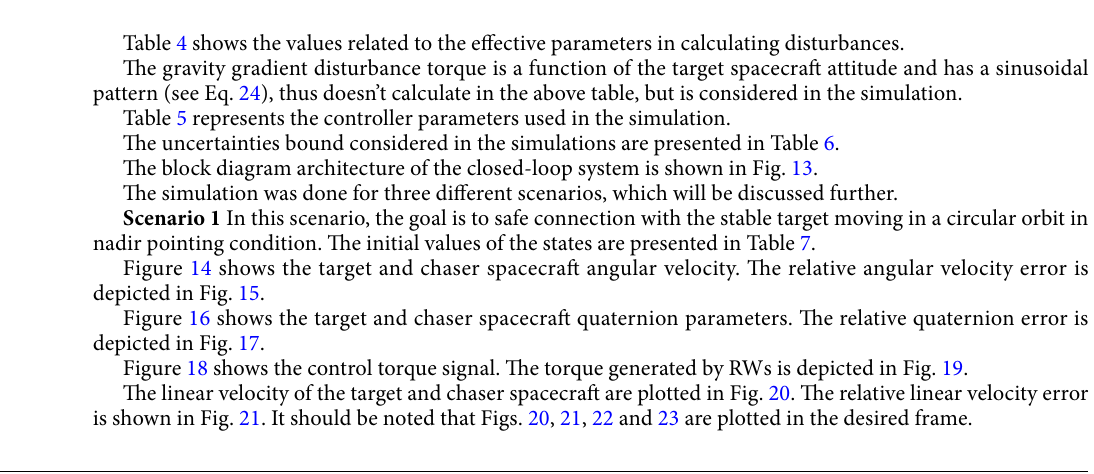
Figure 13. Block diagram architecture of the closed-loop